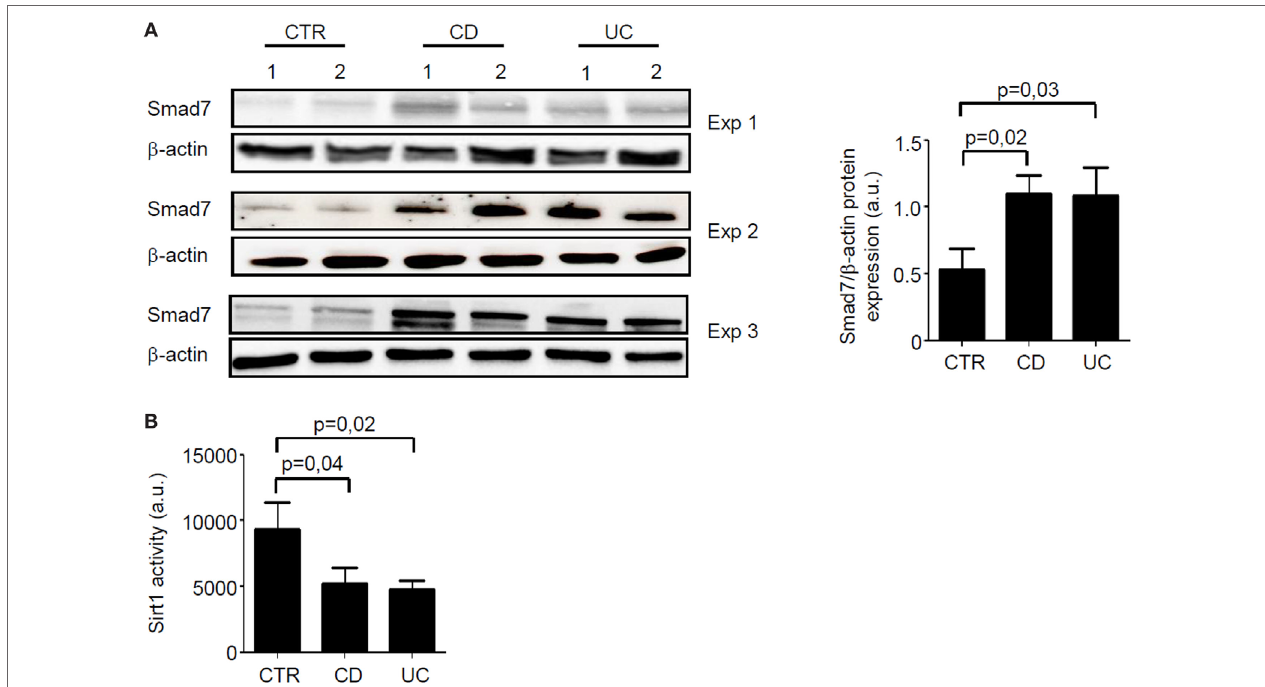
FigUre 1 | In inflammatory bowel disease, increased expression of Smad7 associates with reduced activity of Sirt1. (a) Western blots of three separate experiments (Exp) showing Smad7 and β -actin in total proteins extracted from surgical intestinal specimens of six healthy controls (CTR), six patients with Crohn’s disease (CD), and six patients with ulcerative colitis (UC). Right panel shows the quantitative analysis of Smad7/ β -actin ratio in samples taken from six CTR, six patients with CD, and six patients with UC as measured by densitometry scanning of Western blots. Values are expressed in arbitrary units (a.u.) and indicate mean ± SEM of all the samples. (B) Sirt1 activity was measured in paired samples taken from the same six CTR, six patients with CD, and six patients with UC and used for Smad7 evaluation. Values are expressed in a.u. Data indicate mean ± SEM of all the